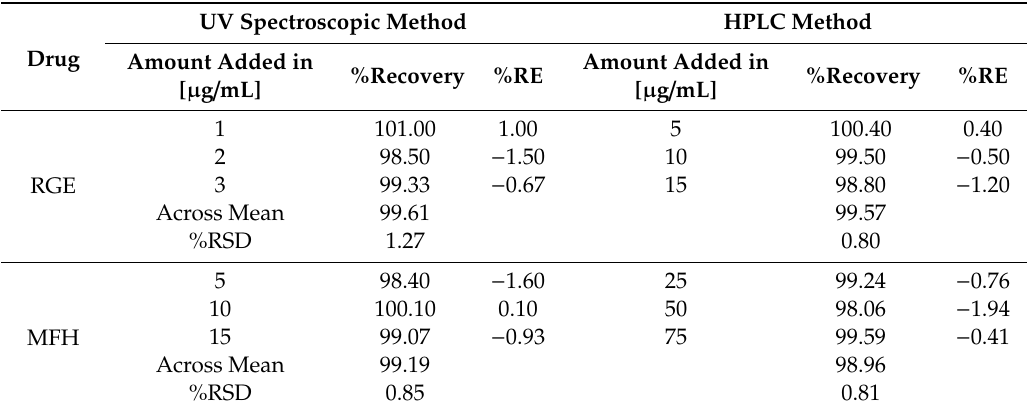
Table 5. Recovery studies.